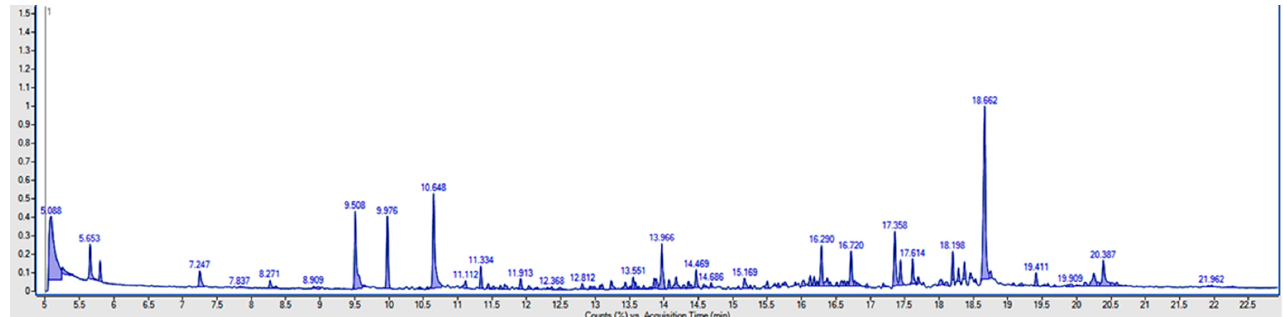
Figure 2. The chromatogram of dental calculus sample (retention times for tetradecanoic acid—16.720 min, pentadecanoic acid—17.358 min, hexadecanoic acid—18.662 min, and octadecanoic acid—20.387 min).